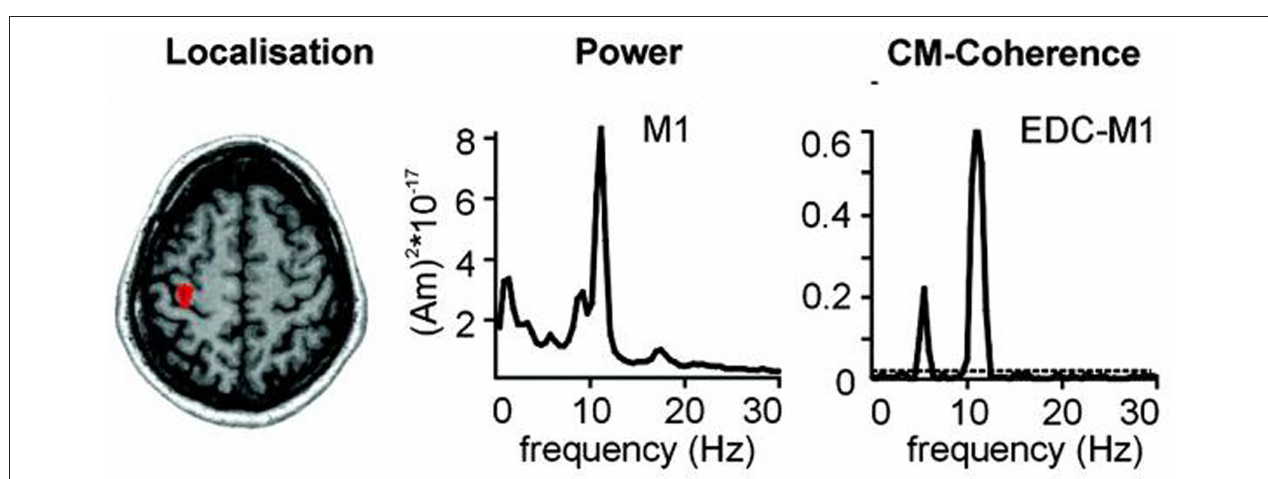
Figure 1 | Schematic representation of the cortical target and the MeA. The MEA provides a spatial mapping of neural activity in the cortical target compatible with the spatial scale of description of the neural field model